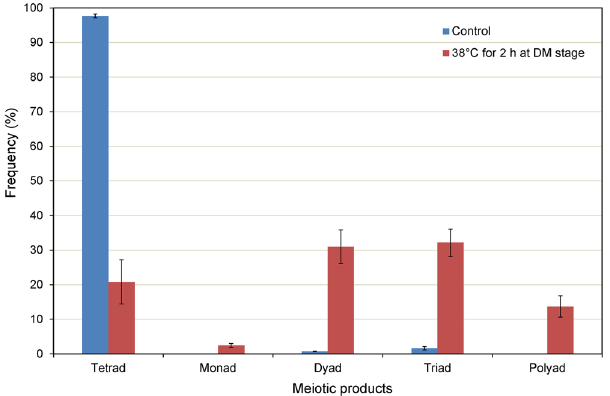
Figure 5. Production of meiotic products after treatment at 38 °C for 2 h during the diakinesis to metaphase I stage. DM, the diakinesis to metaphase I stage. Values are mean ± SE of three